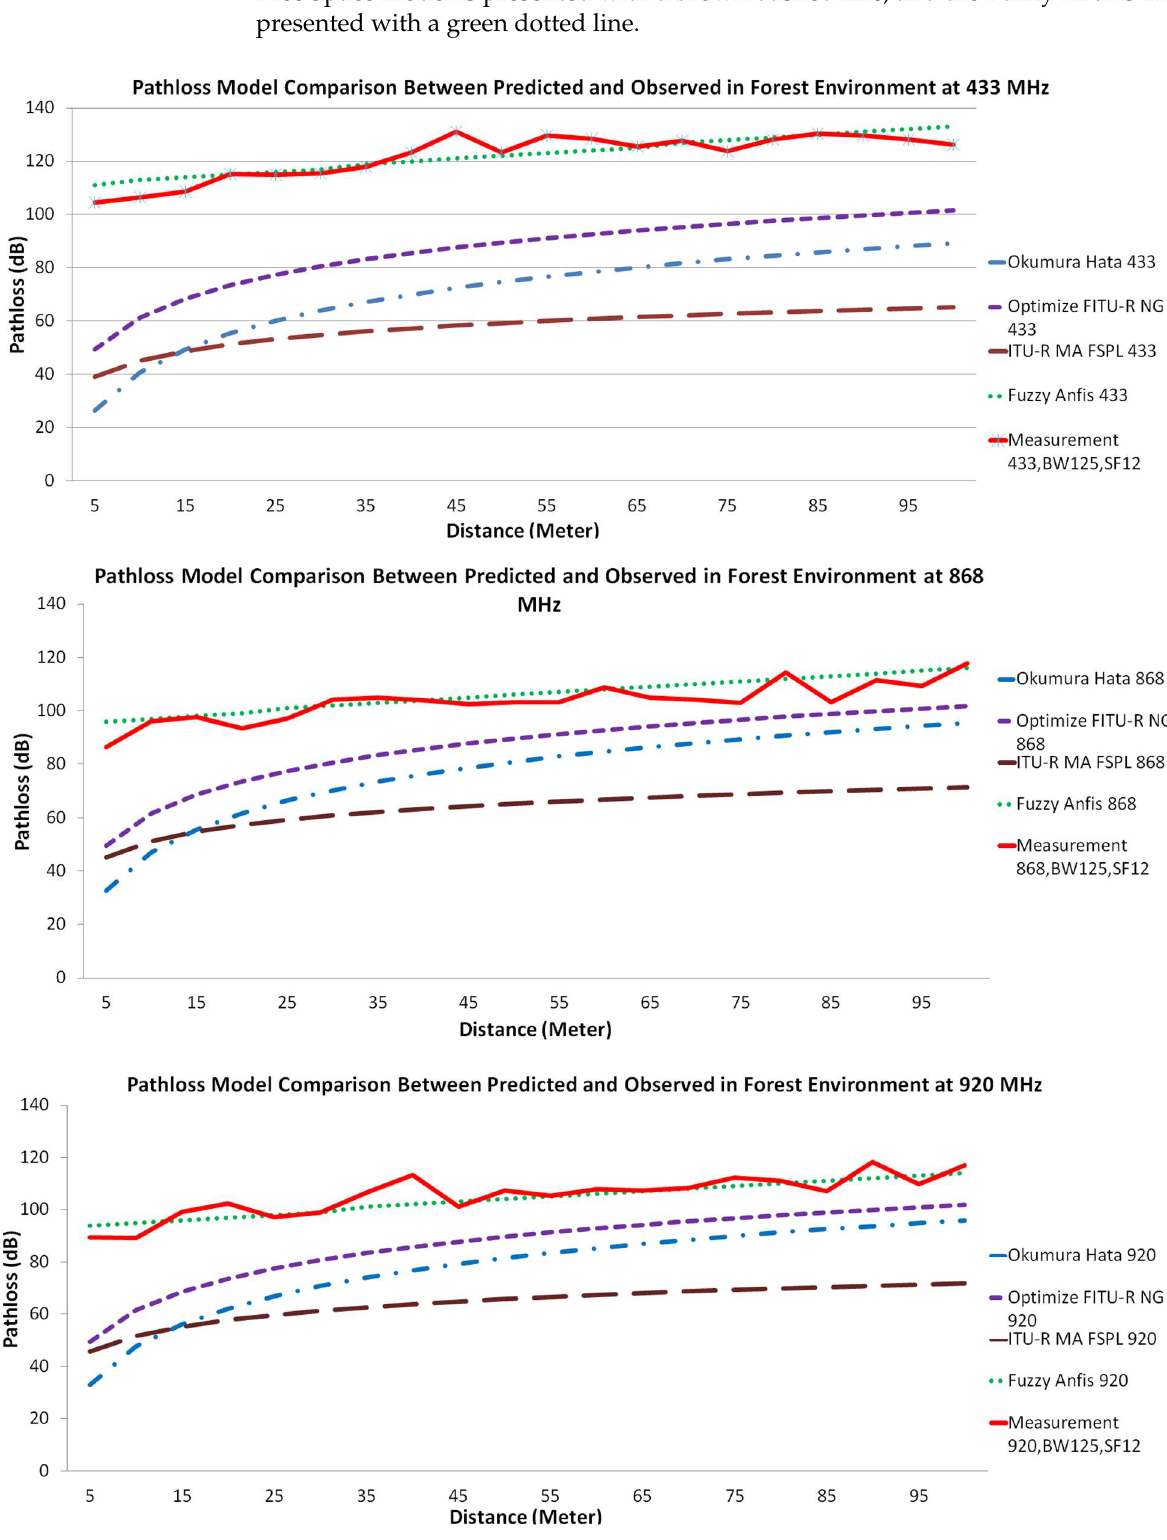
Figure 4. Pathloss model comparison between predicted and observed value in forest environment for frequency carrier ( top ) 433 MHz, ( middle ) 868 MHz, and ( bottom ) 920 MHz.